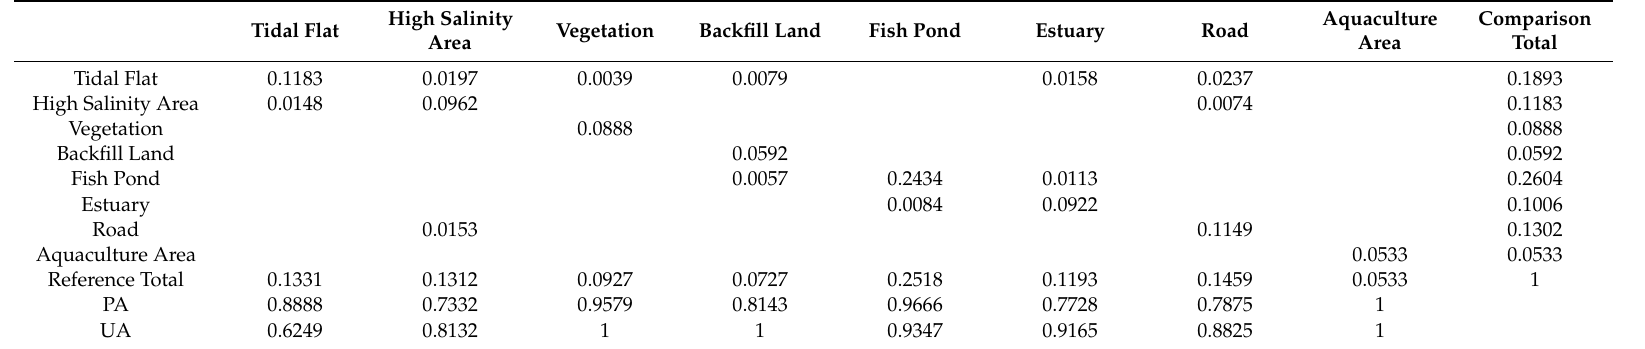
Table 10. Estimated population matrix of the RF method in the Landsat-8 image.